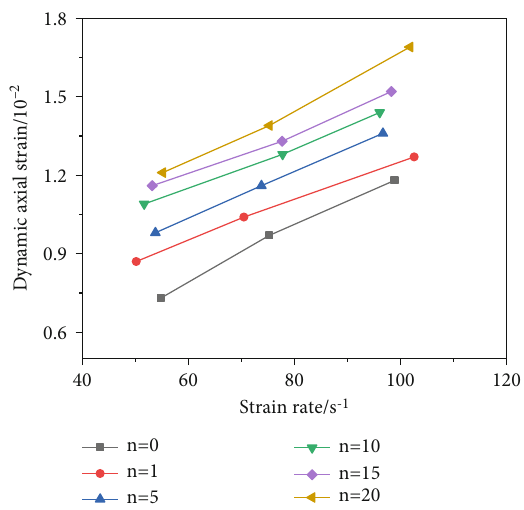
Figure 4: Dynamic compressive strength of sandstone under di ff erent strain rates.